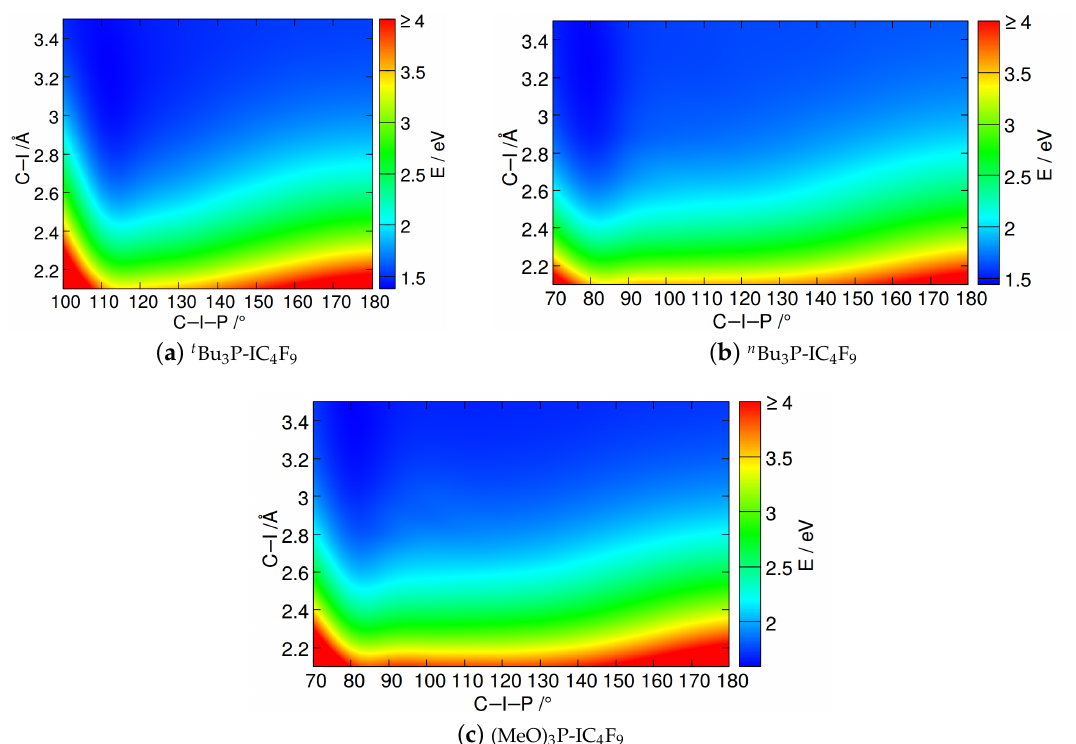
Figure 6. Heatmaps of the T 1 potential energy surfaces of the phosphine and phosphite adducts as functions of the C–I bond length and the C–I–P angle. All other internal coordinates were kept fixed to the minimum geometry parameters of the respective T 1 state. The energy scales on the right refer to DFT and multireference configuration interaction (DFT/MRCI) energies relative to the ground-state minimum. Note the different scales of the x